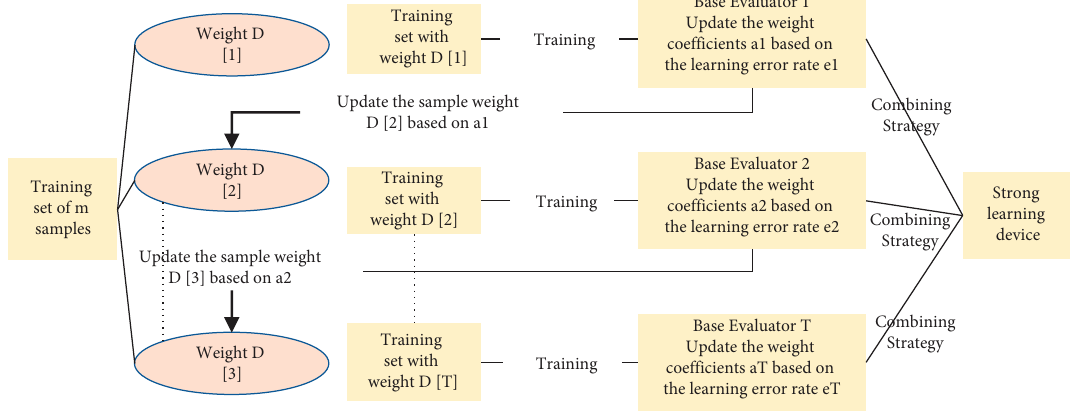
Figure 3: Schematic diagram of